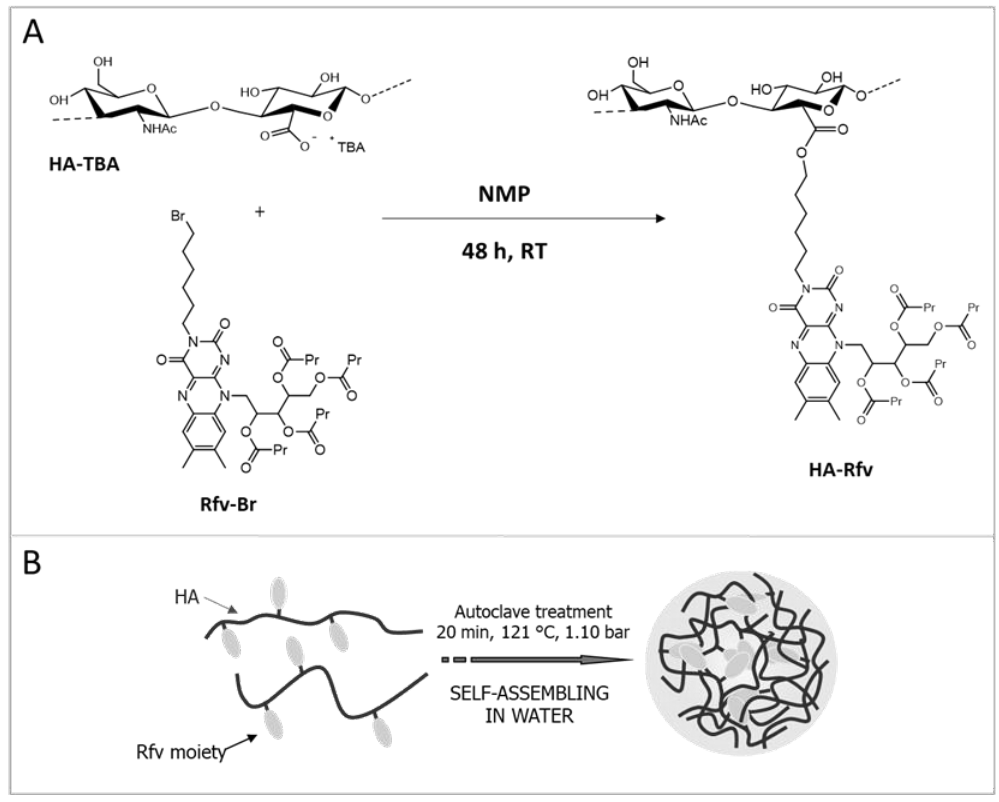
Figure 1. Scheme of HA-Rfv synthesis ( A ); and of NHs formation by autoclave treatment ( B ).